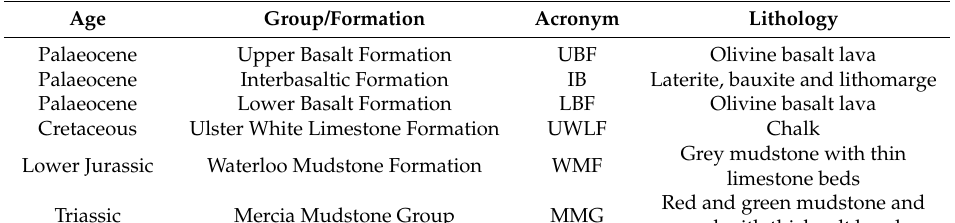
Table 5. Reference summary geology for the Garron Point area.